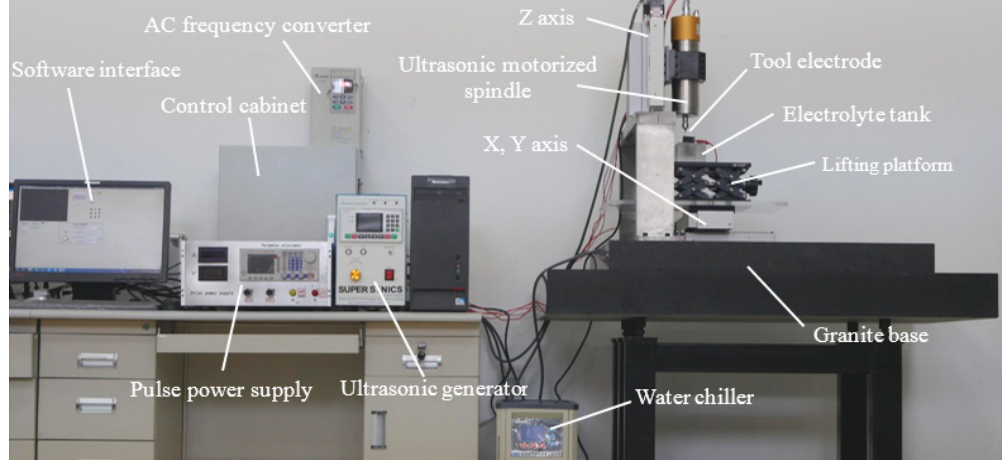
Figure 1. Experimental system for UAECDG.